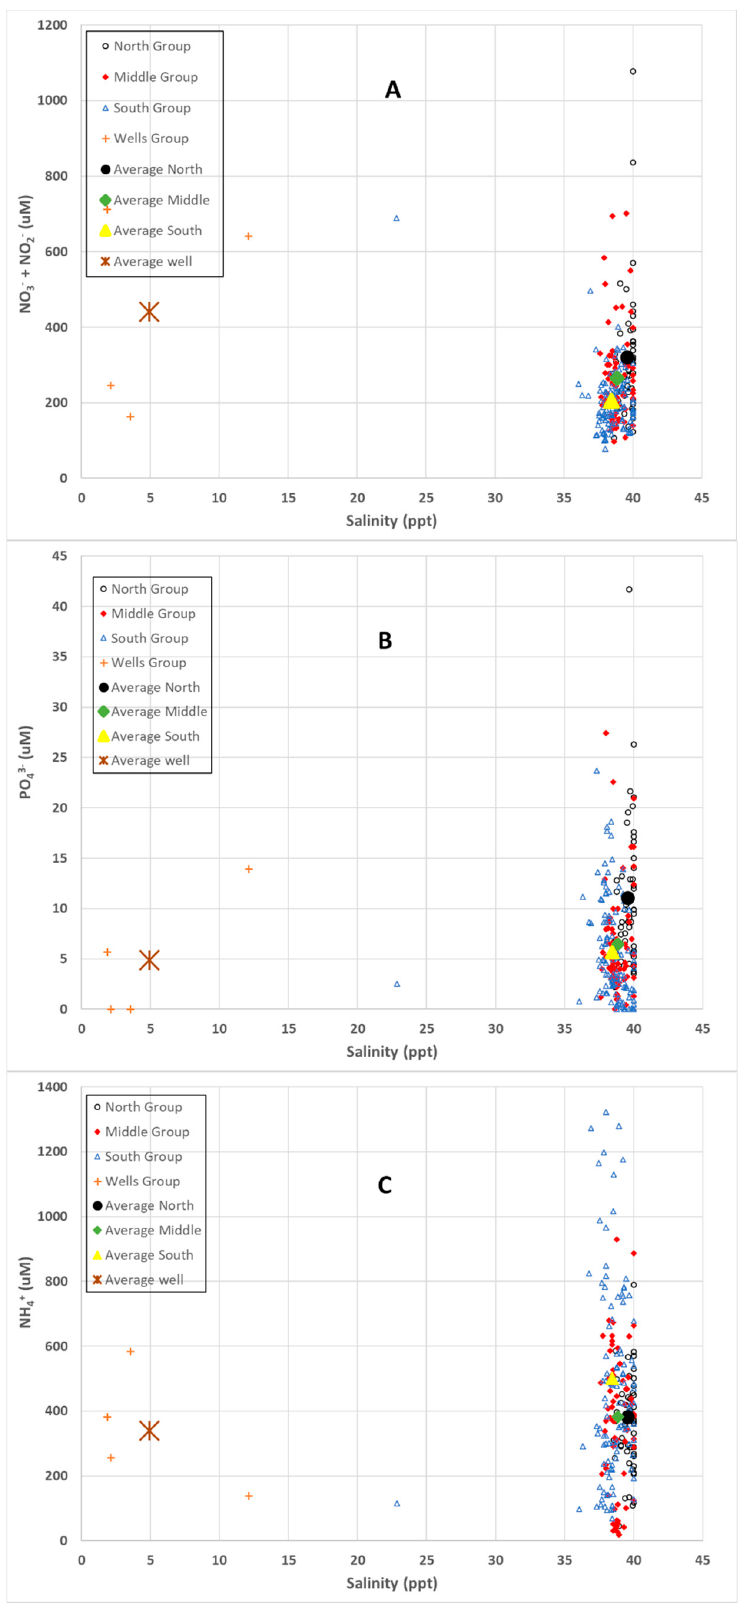
Figure 4. ( A ) Average (NO 3 − + NO 2 − ), ( B ) Average PO 4 3 − and ( C ) Average NH 4 + vs salinity in Gaza coastal shallow groundwater and in deeper wells.